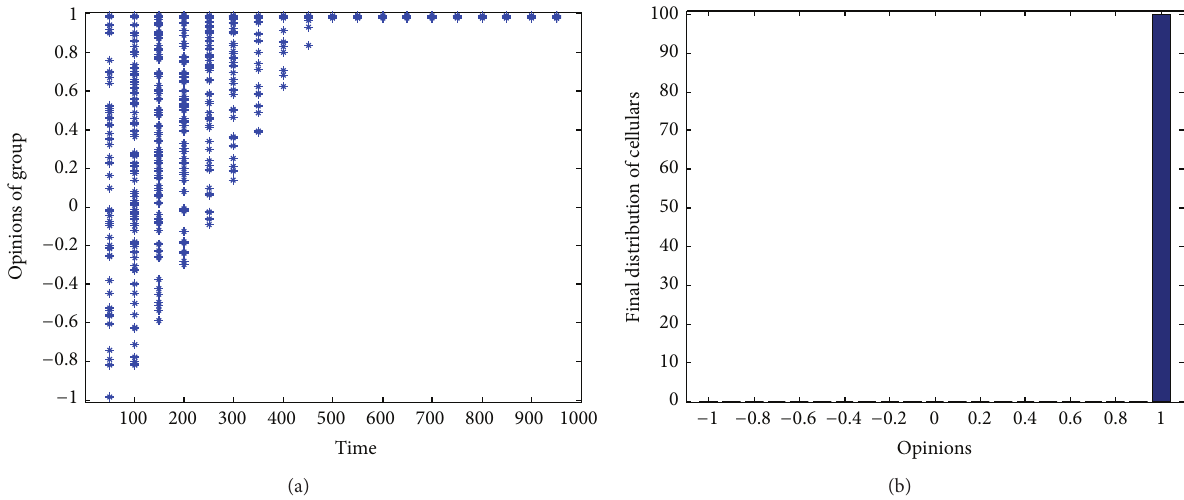
Figure 10: When 𝑎 = 1 , 𝑏 = 𝑐 = 0 , and 𝑁 = 100 , the group shows consensus in fully connected networks. (a) Opinions of group change with times. (b) Histogram of final distribution of group opinions.